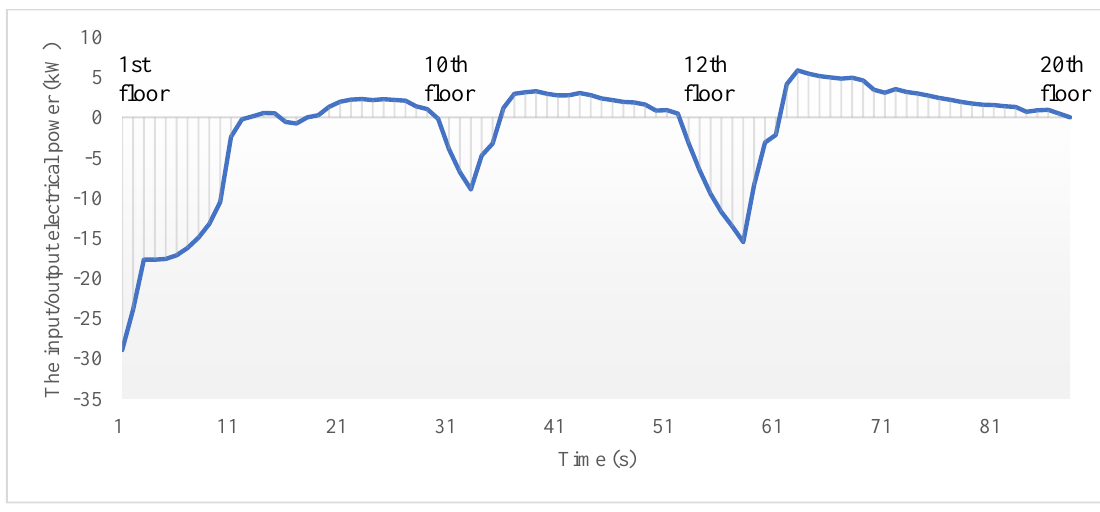
Figure 10. One of the input/output electrical powers of the energy-saving device in upgoing state.